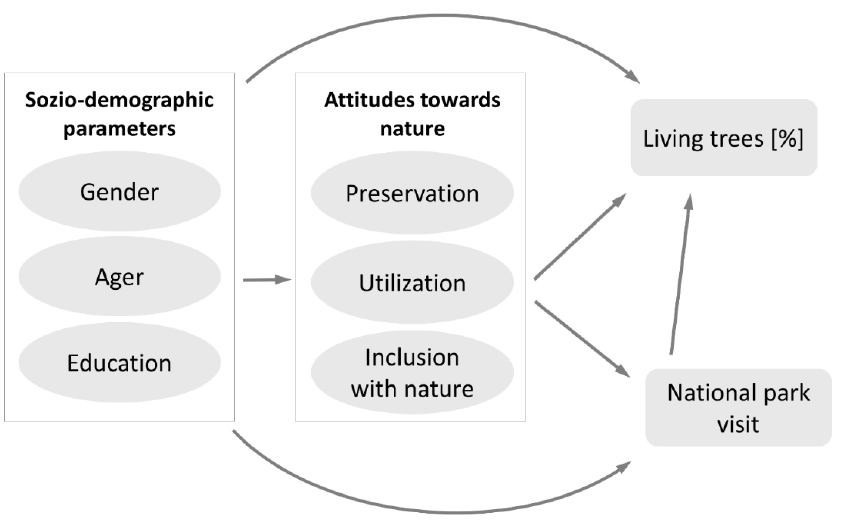
Figure 2. Variables used in the Structural Equation Modeling and the tested relations between the different variables.